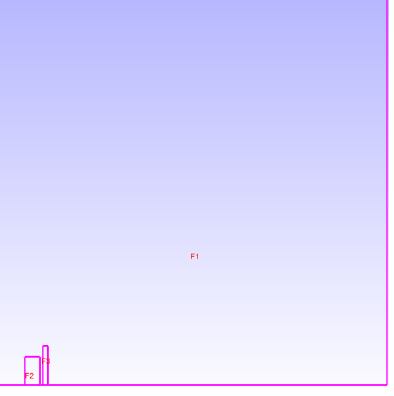
Figure 14. Modeled geometry of the